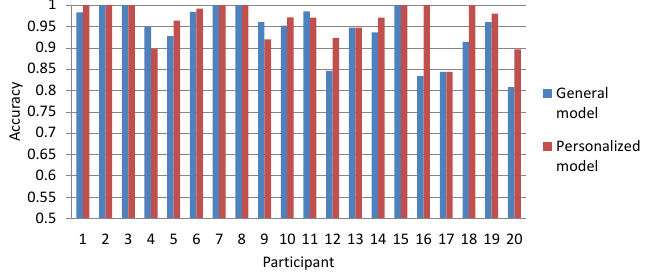
Figure 3. Accuracy evaluation of the general model versus the personalized model, for identifying unusual mobile user